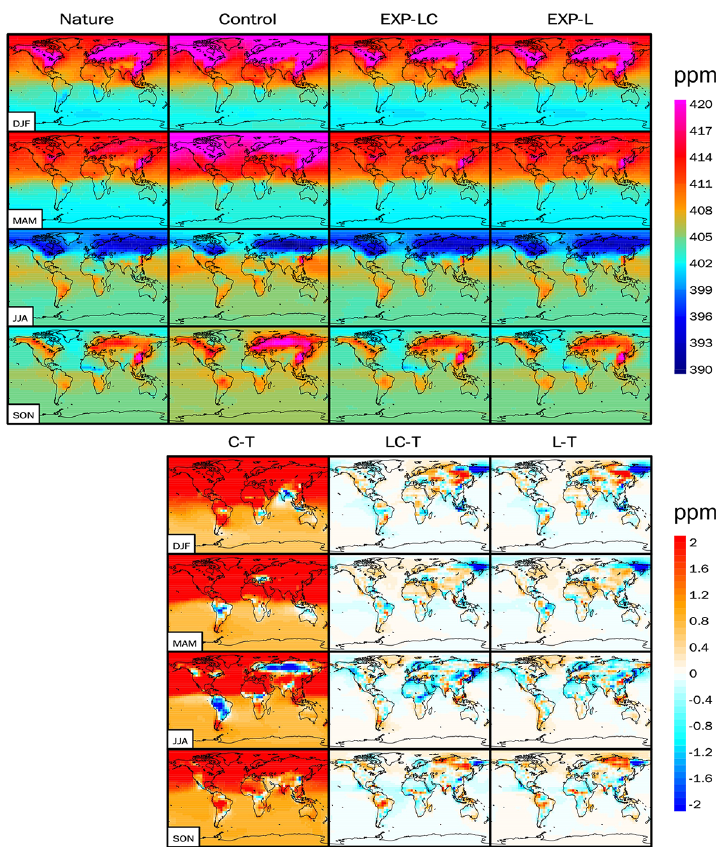
Figure A3. The top four columns are the CO 2 climatological seasonal cycle of the nature run, control run, EXP-LC, and EXP-L from December to February (DJF), March to May (MAM), June to August (JJA), and September to November (SON). The bottom three columns are the difference between the control run and nature run (C–T), between EXP-LC and nature run (LC-T), and between the EXP-L and nature run